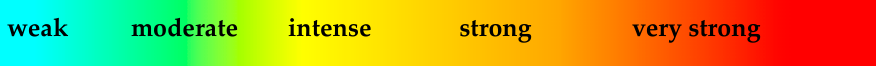
Legend Colour bar related to the intensity of the phenomena in progress from DPC.